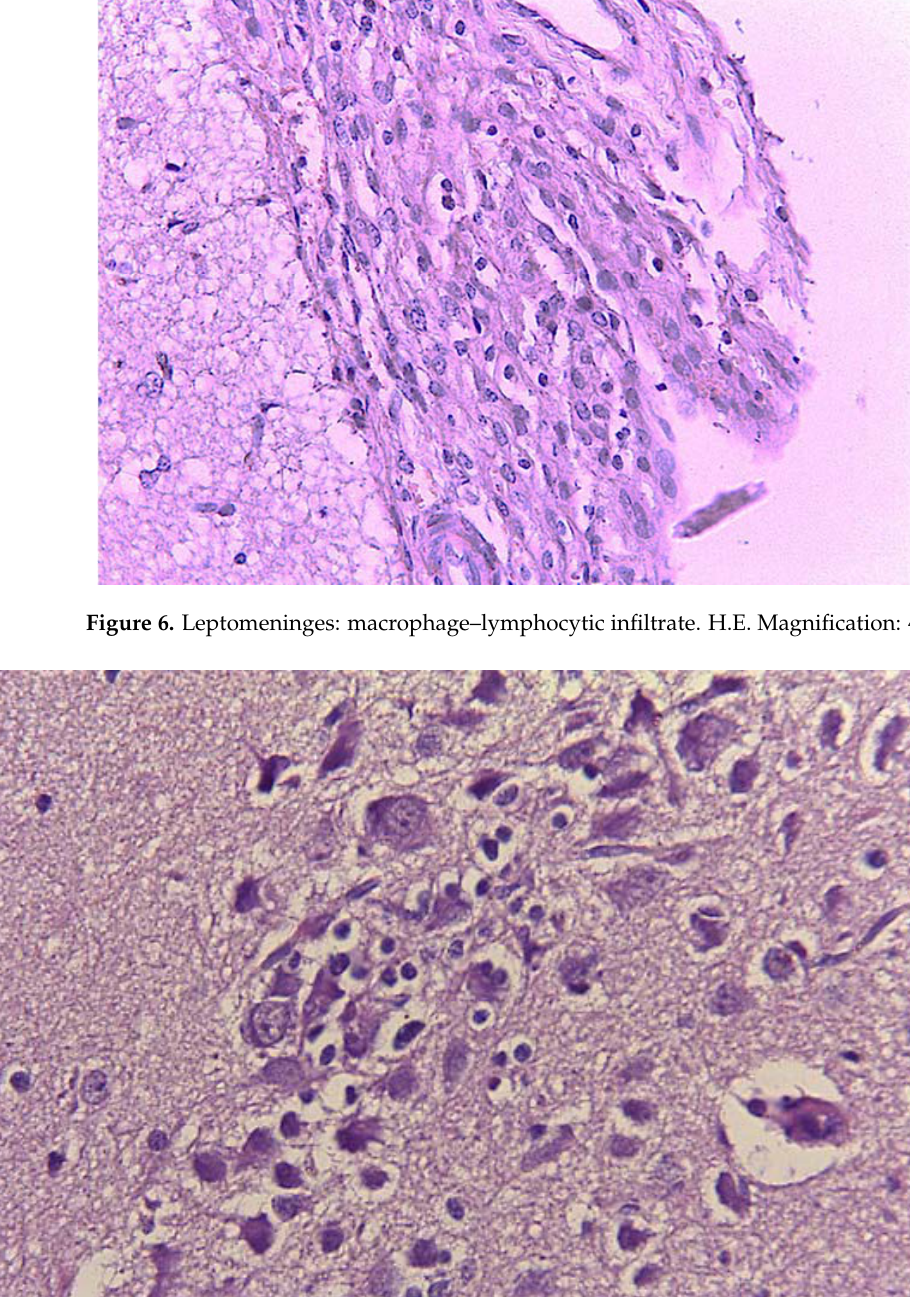
Figure 8. Perivascular cuffing of macrophage–lymphocyte cells. H&E. Magnification: 40 ×.